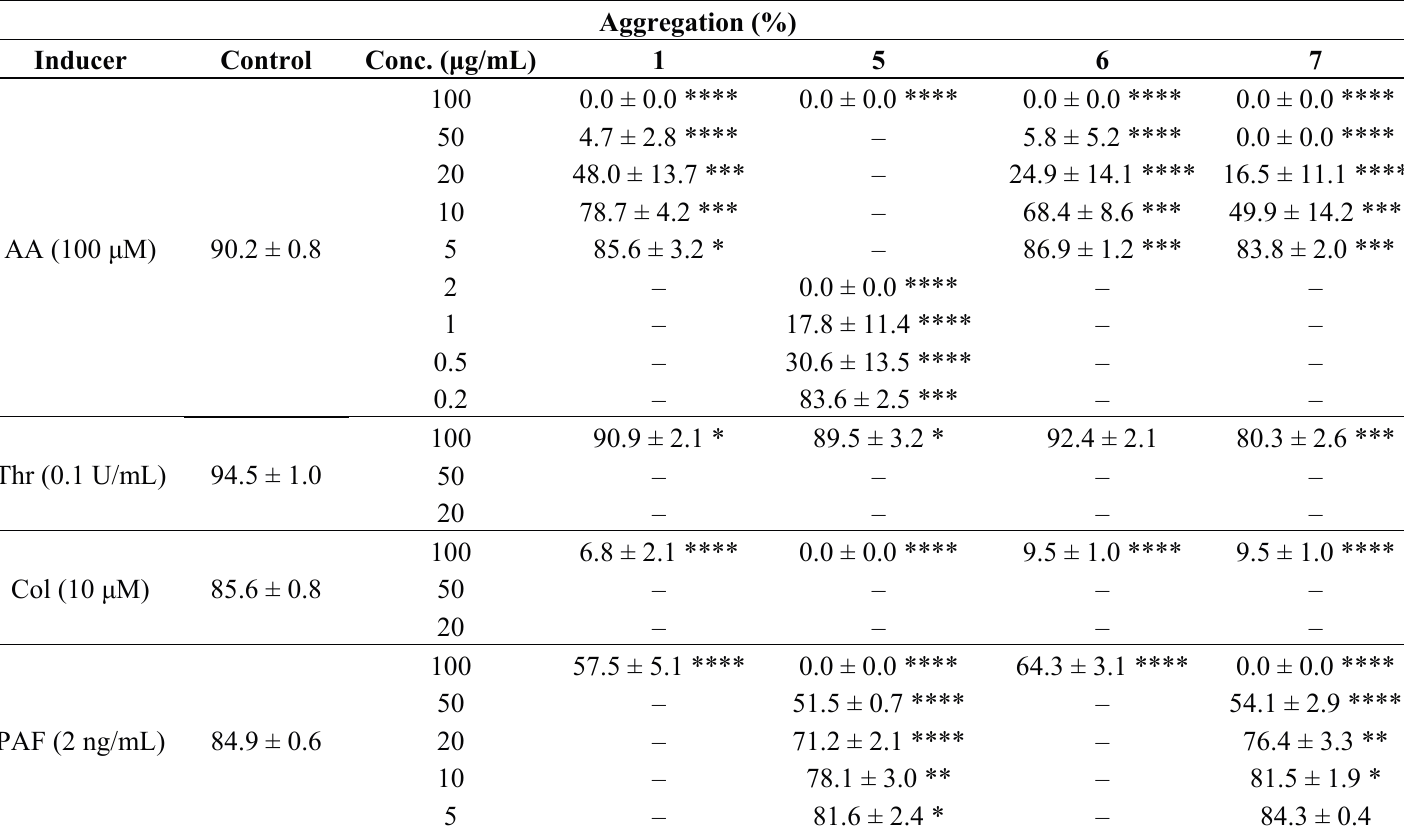
Table 2. Antiplatelet aggregation effects of 1 , 4 , and 5 – 7